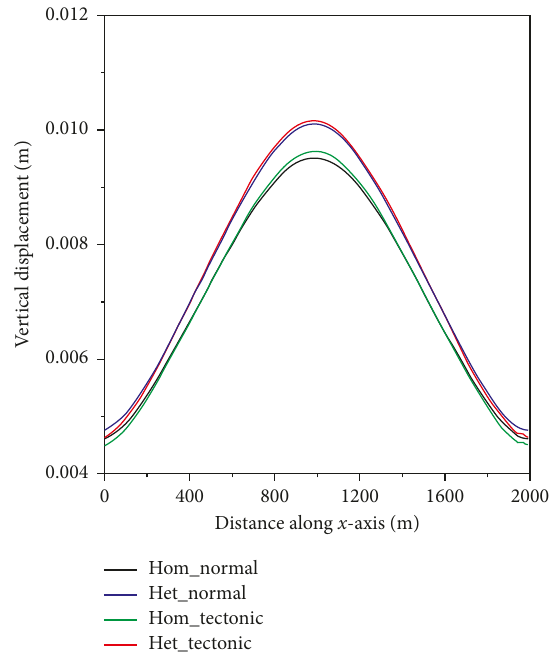
Figure 12: Vertical displacement of top of caprock under the additional tectonic stress ( V DP (cid:30)